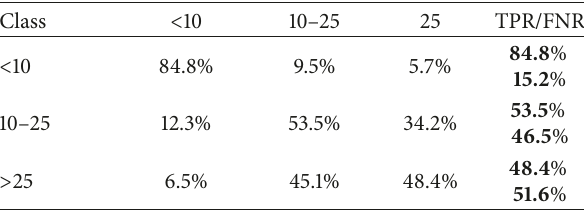
Table 5: Confusion matrix of three-class classification for Belisario using a RBT. Rows represent the true class and columns represent the predicted